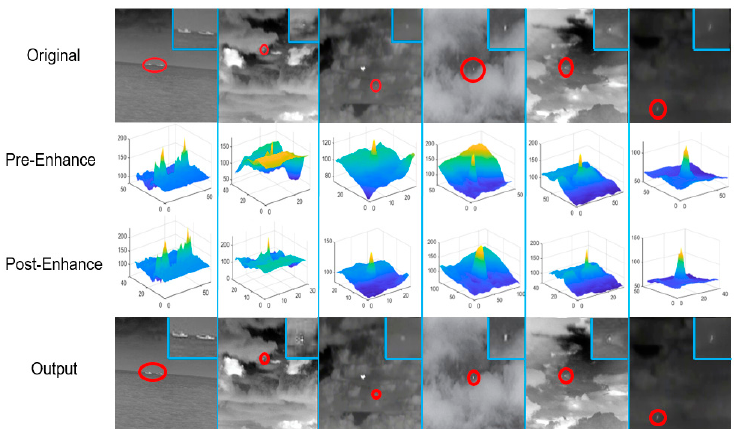
Figure 10. Enhancing small targets.